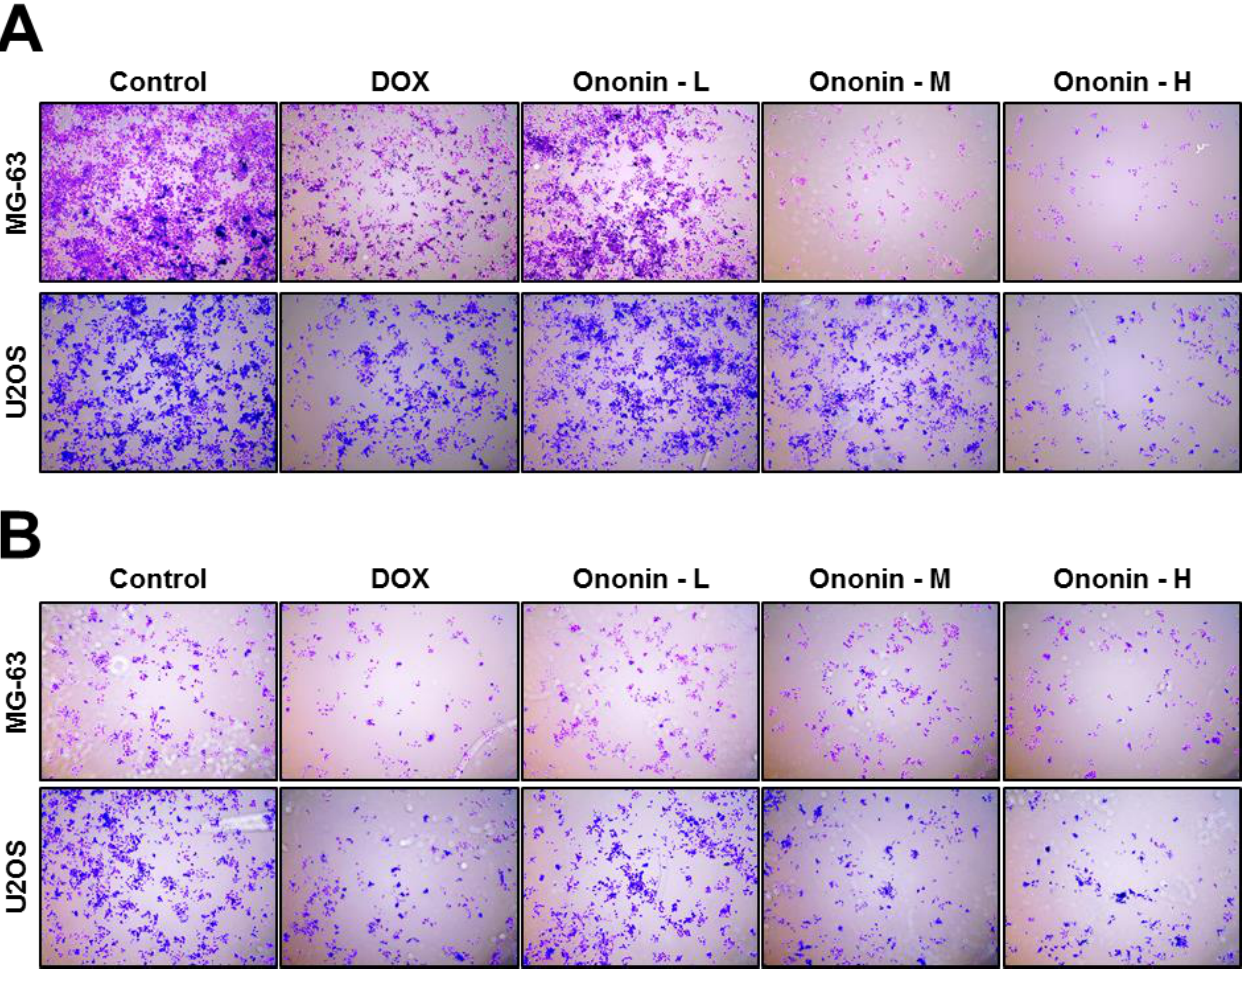
Figure 3. ( A ) Transwell assay analysis of MG-63 or U2OS treated with ononin for migration activity. ( B ) Matrigel-coated transwell was used here for evaluating the anti-invasion potential of ononin on osteosarcoma cells. Ononin at 0.1 μM was labeled as - L, 0.3 μM was highlighted as -M, and 1 μM was shown as -H.